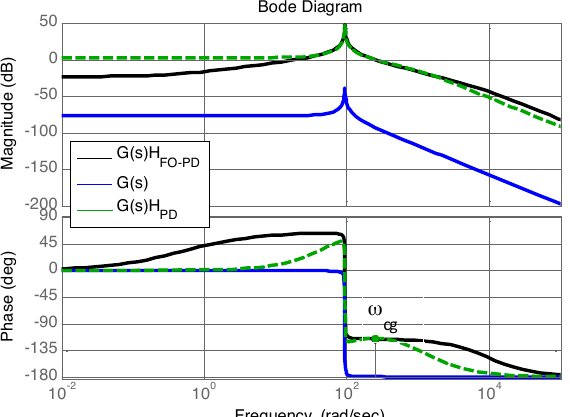
Fig. 5 Frequency response of the uncompensated smart beam and of the open loop systems with fractional and integer order PD